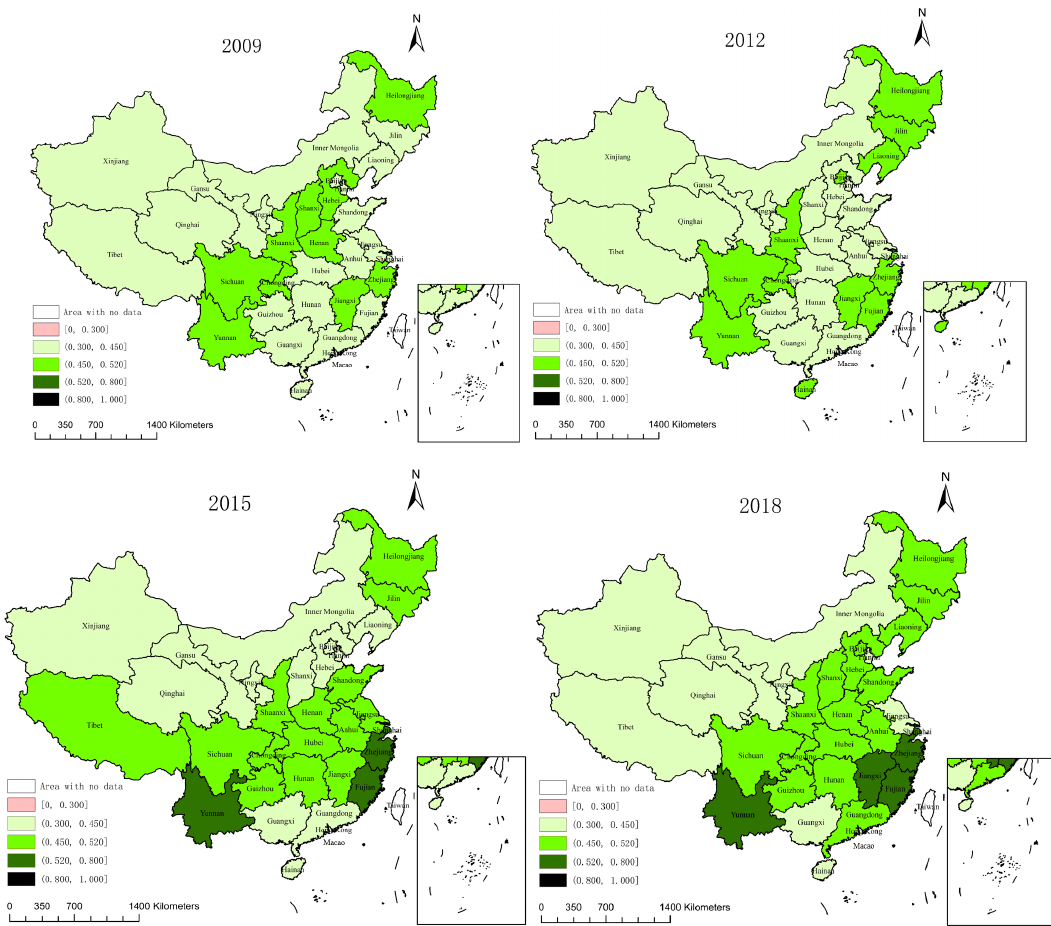
Figure 2. The spatial layout of China’s FES levels.